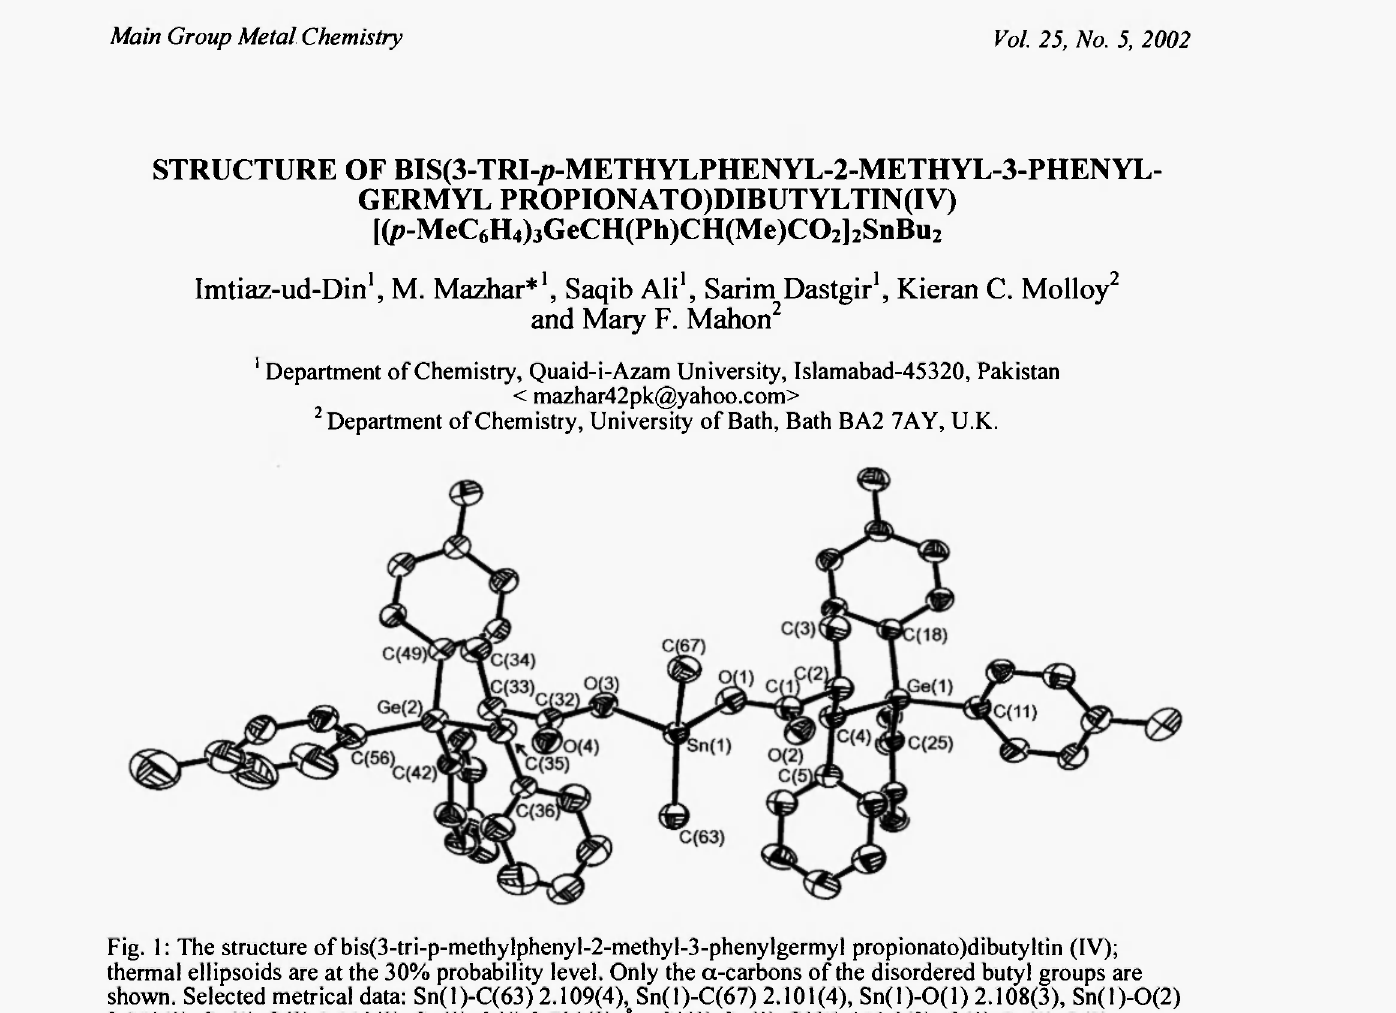
Fig. 1: The structure of bis(3-tri-p-methylphenyl-2-methyl-3-phenylgermyl propionato)dibutyltin (IV); thermal ellipsoids are at the 30% probability level. Only the α-carbons of the disordered butyl groups are shown. Selected metrical data: Sn(l)-C(63) 2.109(4), Sn(l)-C(67) 2.101(4), Sn(l)-0(1) 2.108(3), Sn(l)-0(2) 2.553(3), Sn(l)-0(3) 2.110(3), Sn(l)-0(4) 2.701(3) A; C(63)-Sn(l)-C(67) 151.0(2), 0(l)-Sn(l)-0(2) 55.3(1), 0(3)-Sn(l)-0(4)